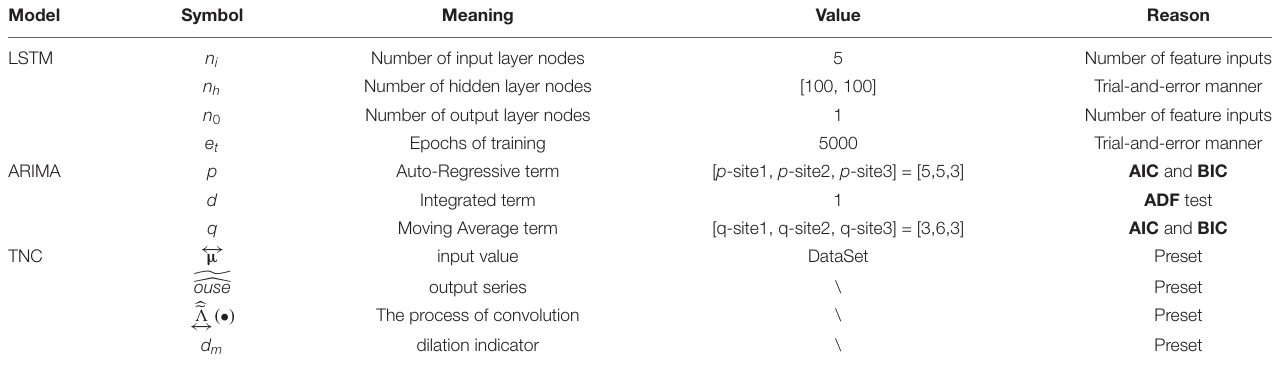
TABLE 3 | Compare the parameter settings of each model.